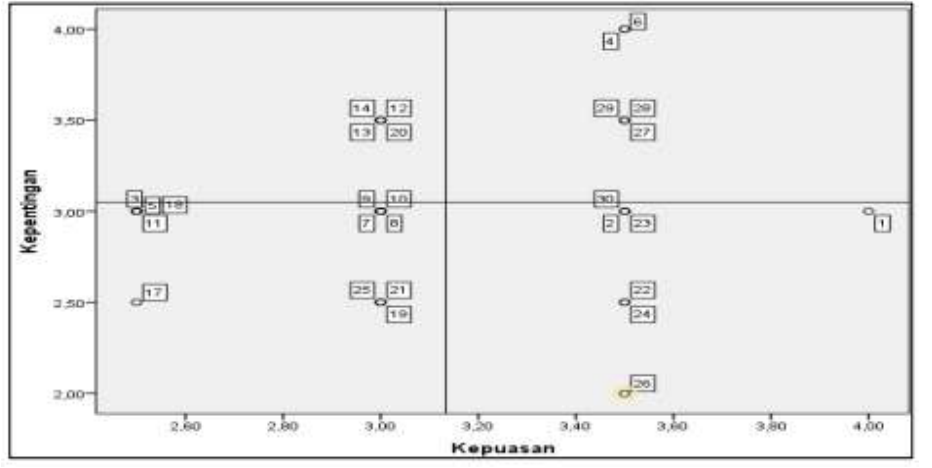
Figure 8. Result of Importance Performance Analysis (IPA) East Belitung Source: Processed,